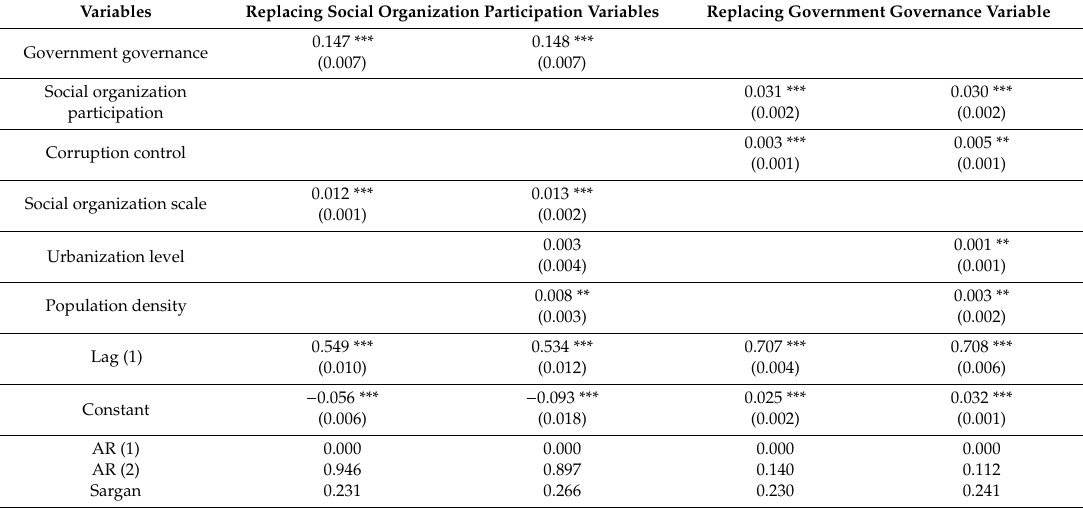
Table 10. Robustness test by replacing the indicators.